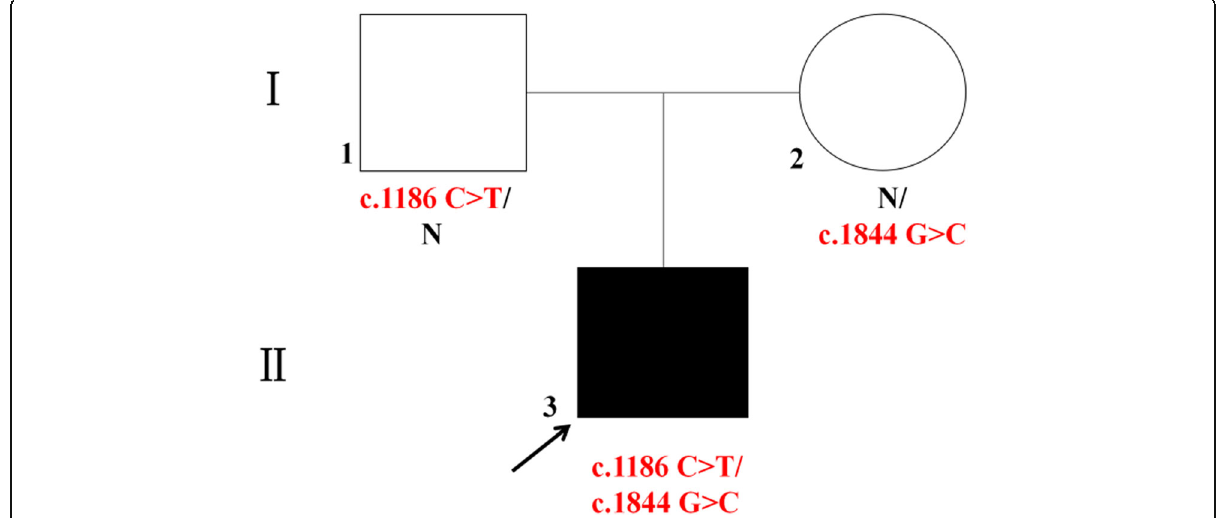
Fig. 1 Pedigree of TWNK mutations in this family with MDS (Filled symbols indicate affected individuals; arrowhead indicates the